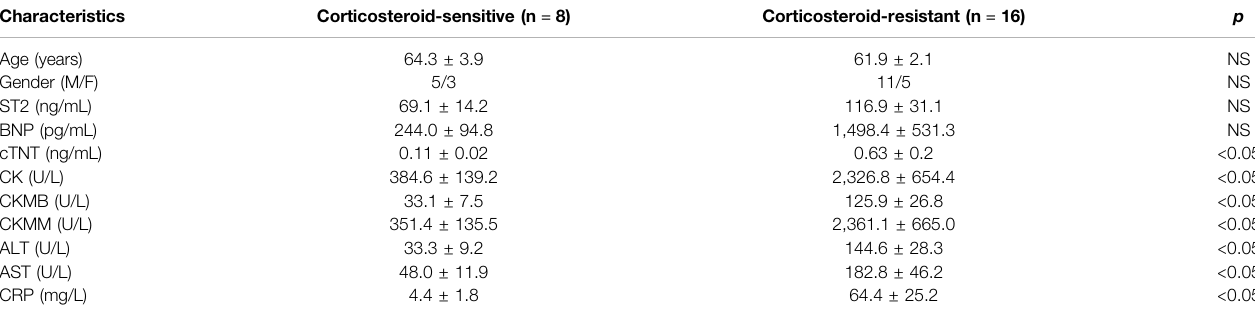
TABLE 3 | Comparison of corticosteroid-sensitive and corticosteroid-resistant ICI-associated myocarditis patients. Characteristics